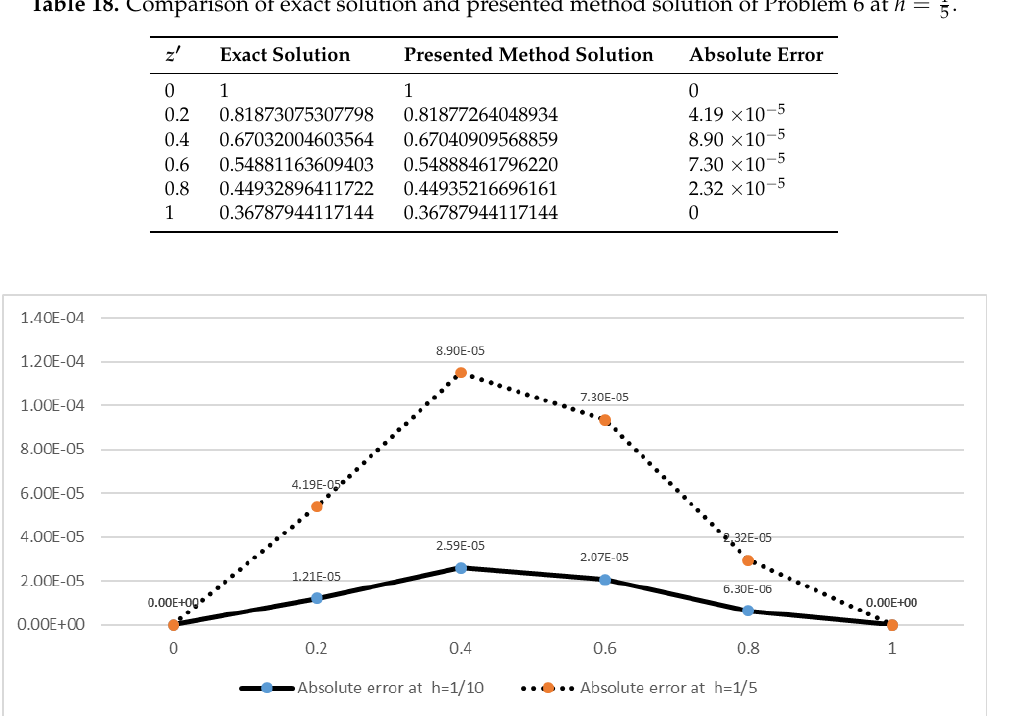
Table 18. Comparison of exact solution and presented method solution of Problem 6 at h = 1